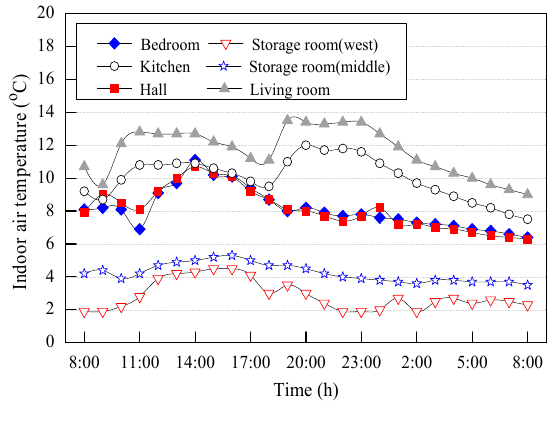
Figure 5. Indoor air temperature.